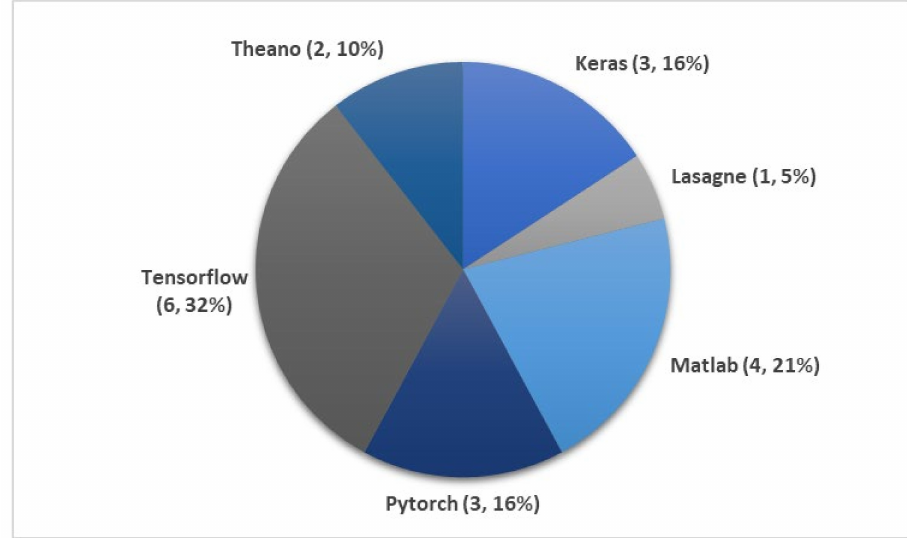
Figure 1. Pie chart representation of the number of times (19 in total) and percentage each deep learning (DL) tools were used to develop DL models in automated sleep stage classification studies as listed in Tables